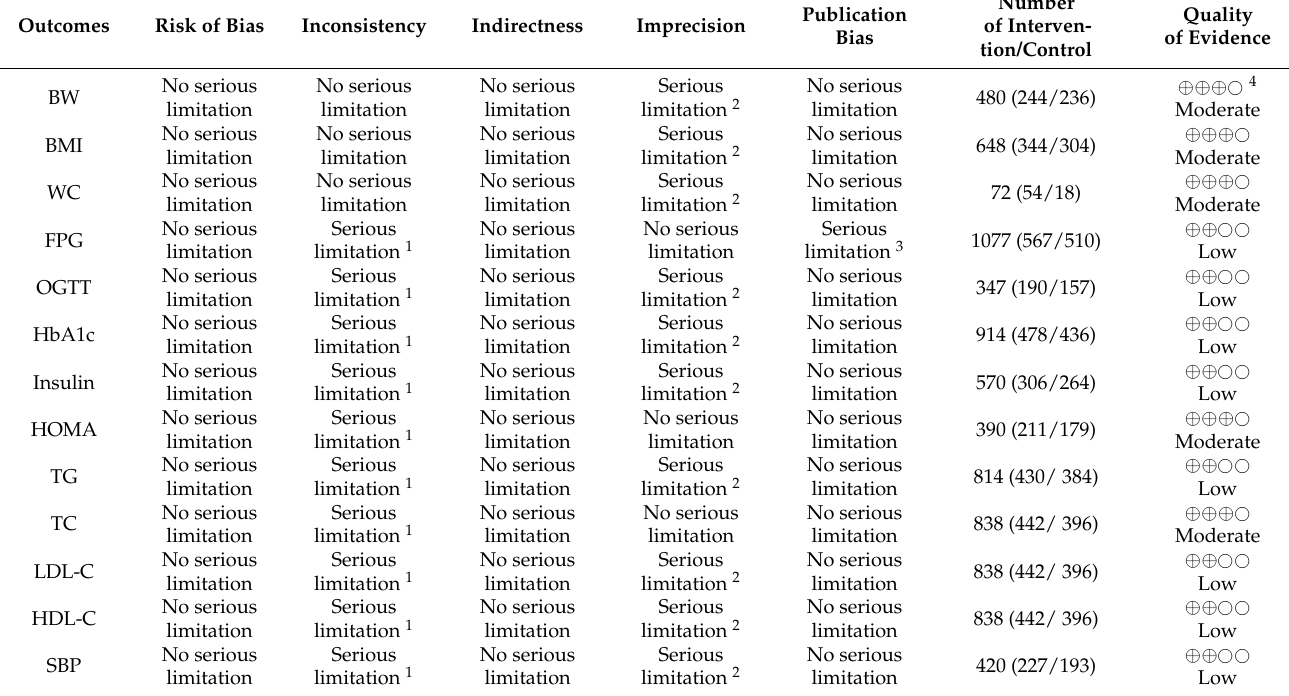
Table 5. GRADE profile of ginseng supplementation for cardiovascular